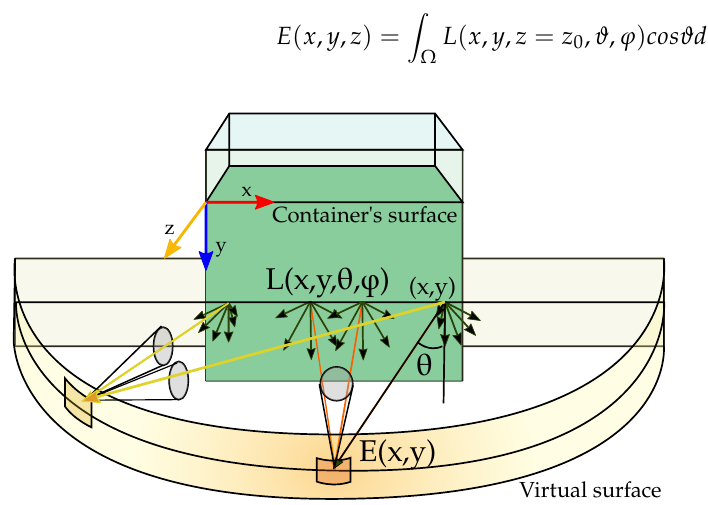
Figure 3. Virtual surface that encloses the